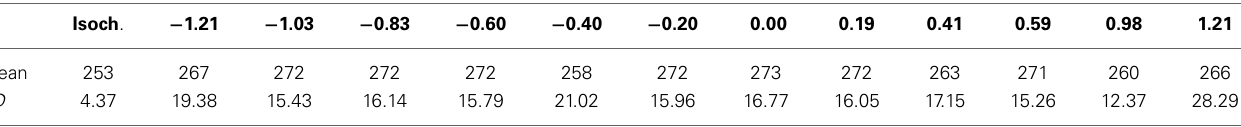
Table 1 | Number of taps per condition (columns = β value). Isoch